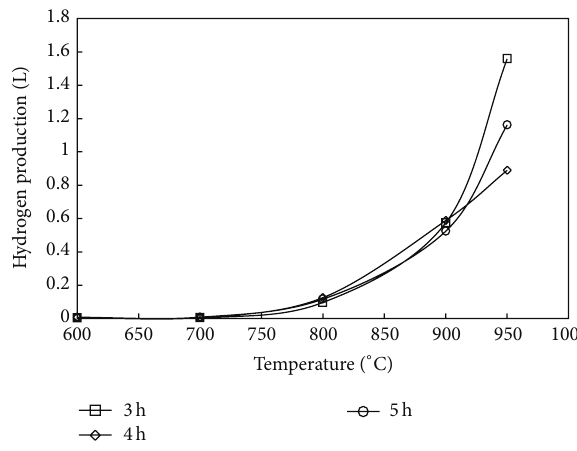
Figure 12: The catalytic activity of different cobalt calcination